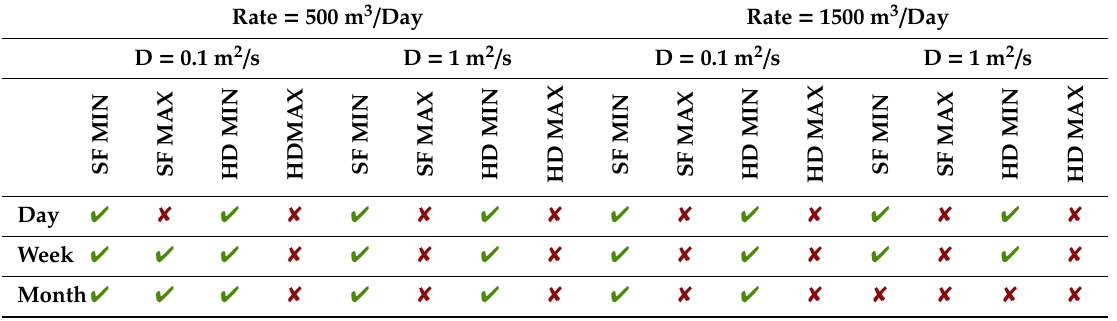
Table 4. Tomographic method capability to reconstruct at least 2 / 3 of the true velocity anomaly intensity, for each combination of simulation